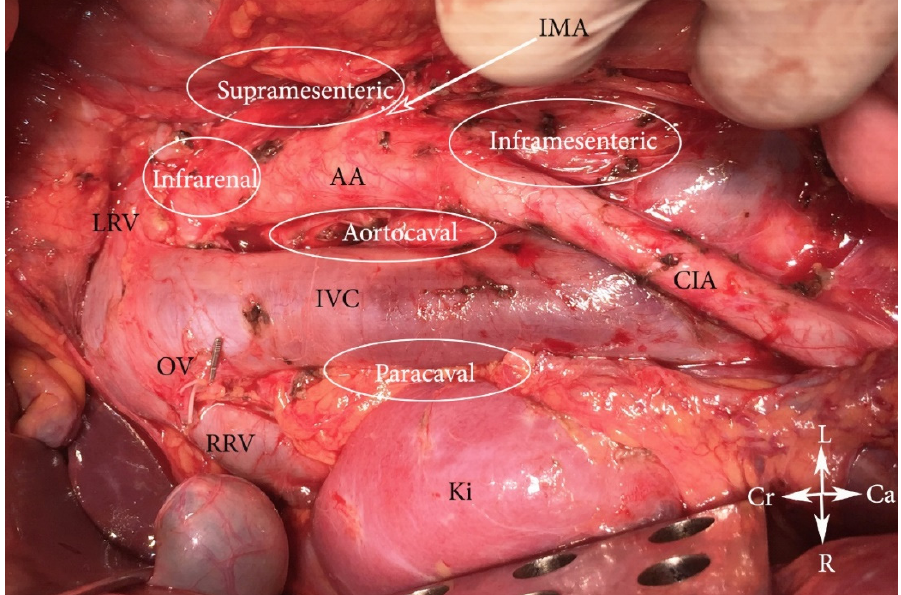
Figure 6. Regions of PALND (open surgery). CIA—common iliac artery, IVC—inferior vena cava, AA—abdominal aorta, RRV—right renal vein; LRV—left renal vein, OV—ligated right ovarian